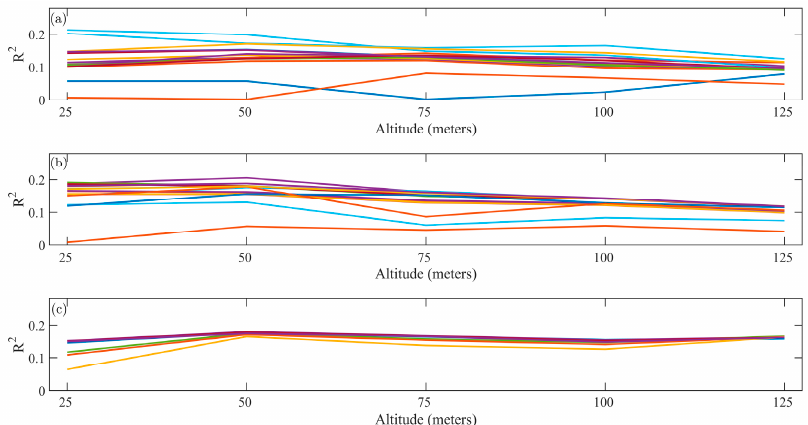
Figure A2. Polyline of R 2 between index and chlorophyll contents using E1-E18. ( a ) RGB color space system with background; ( b ) RGB color space system without background; ( c ) HSV color space system without background.